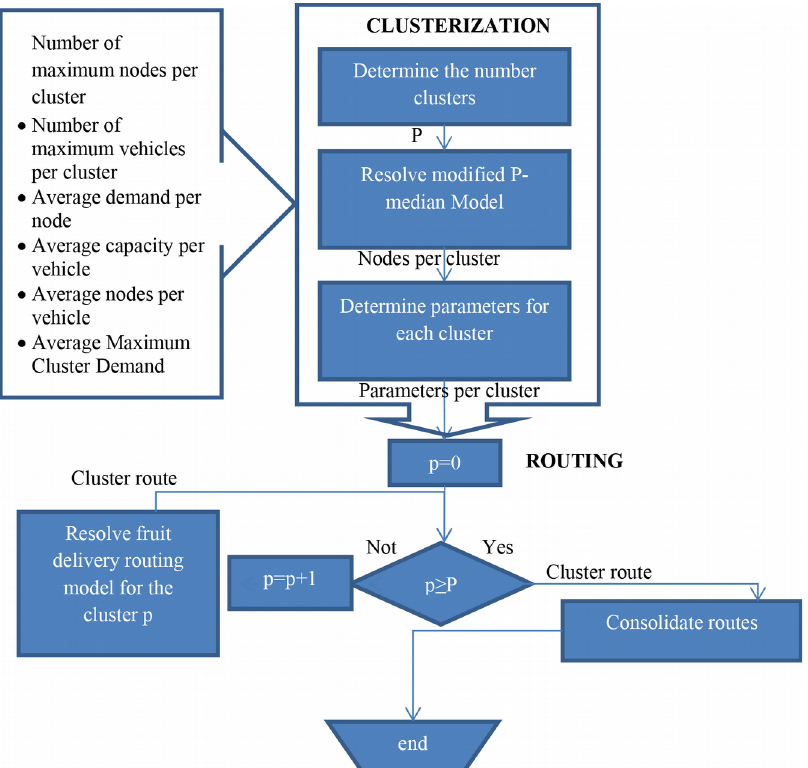
Figure 1. Phases and stages for finding the optimal solution using the model